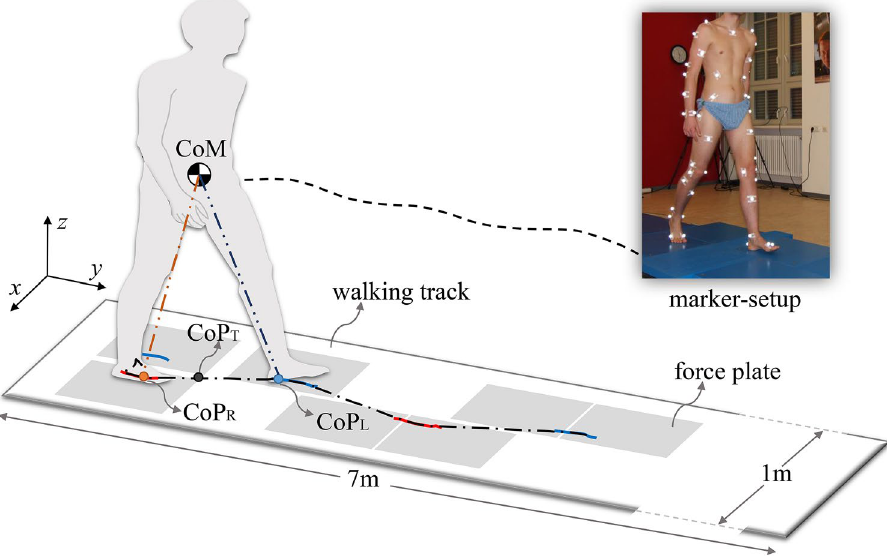
Figure 9. Experimental setup overview. CoP L , CoP R and CoP T denote the left leg, right leg and total center of pressure,